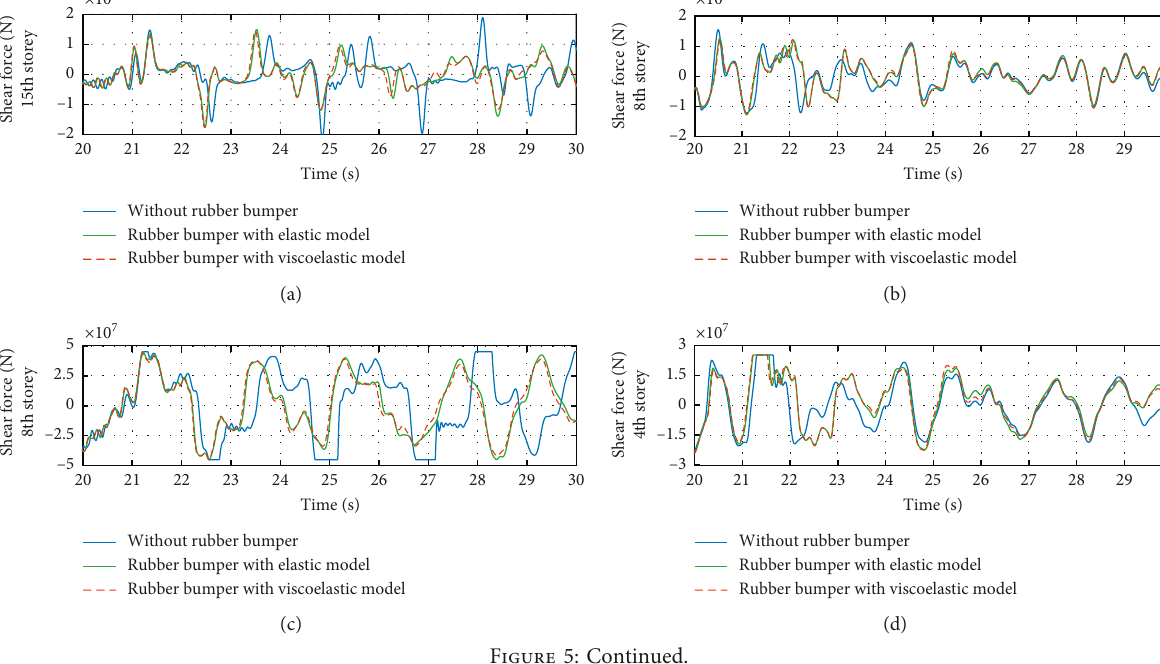
Figure 4: Displacement time-history with three different models of collision for (a, c, e) left building storeys and (b, d, f) right building storeys. ×10 2